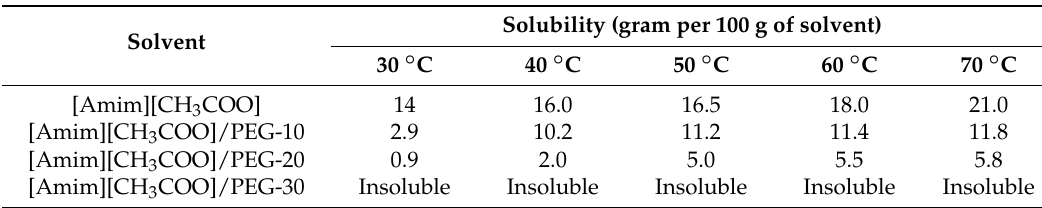
Table 1. Solubility of microcrystalline cellulose in the ILs at different temperatures.